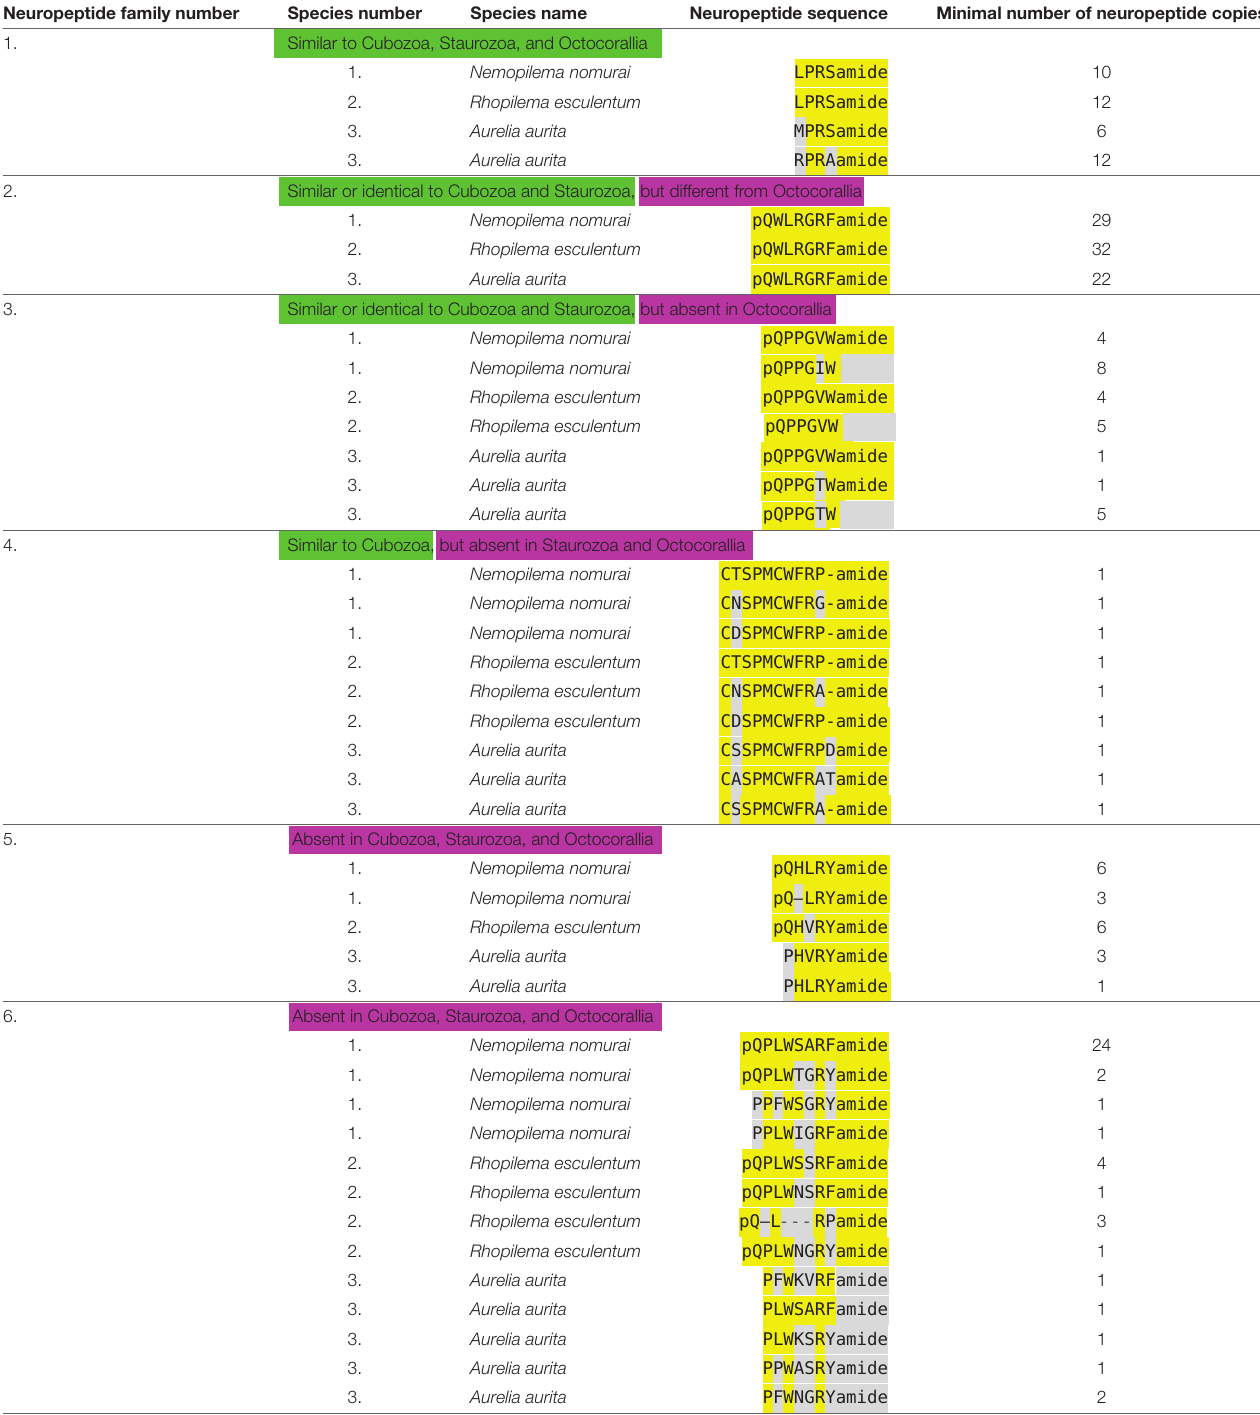
TABLE 2 | An overview of scyphozoan neuropeptide families. Neuropeptide family